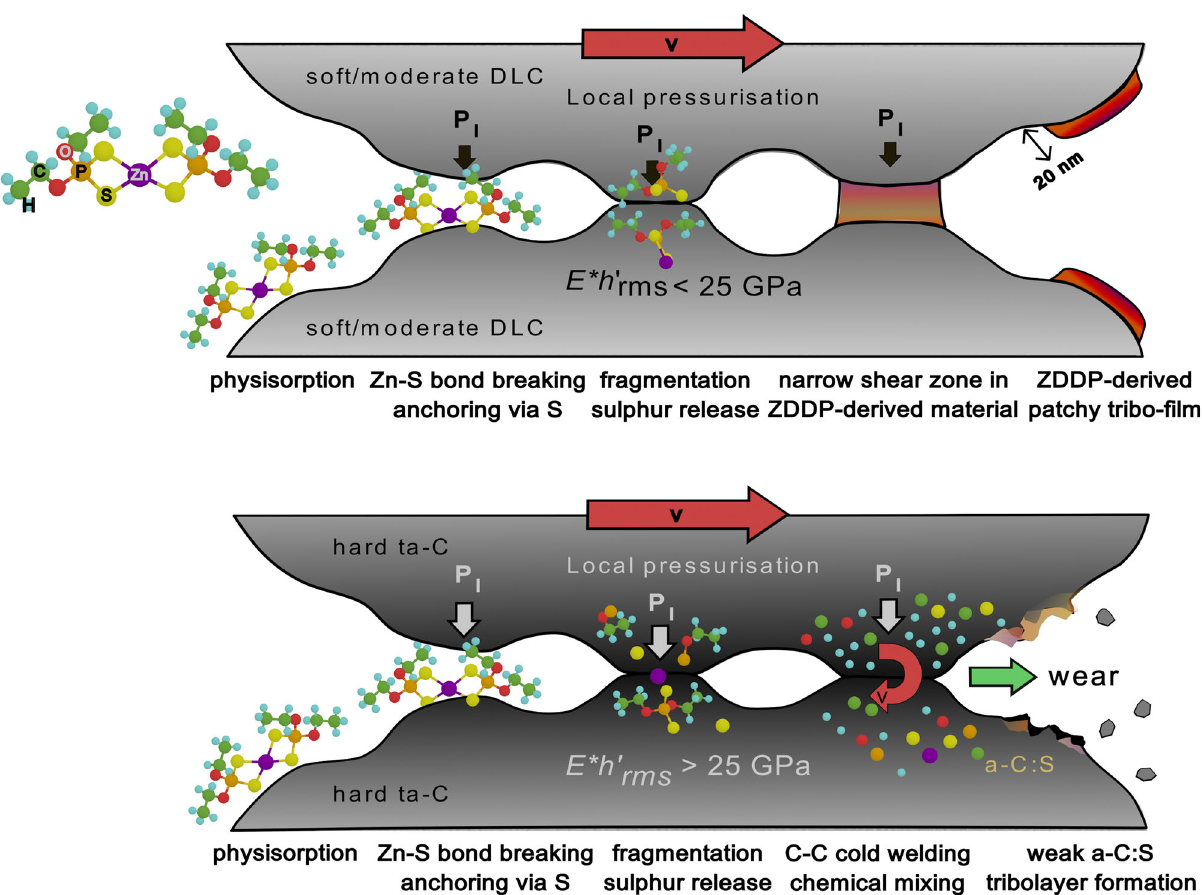
Fig. 9 Schematic representation of likely scenarios for DLC coatings lubricated by ZDDP-additivated oils. a Formation of ZDDP-derived patchy anti- wear tribo fi lms on soft DLC coatings (when E (cid:4) h 0 25 GPa) and b wear of hard ta-C rms <